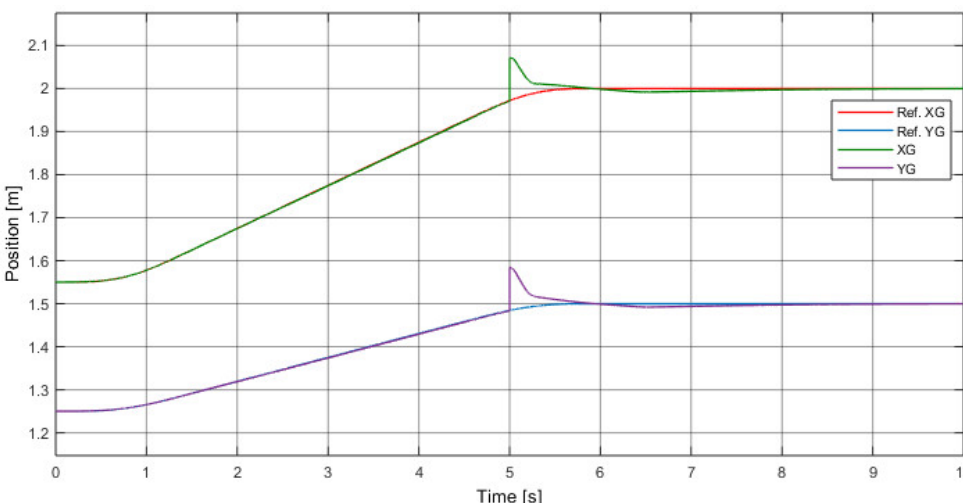
Figure 24. Positioning response of the planar CDPR in the presence of disturbance of a fuzzy PID controller.